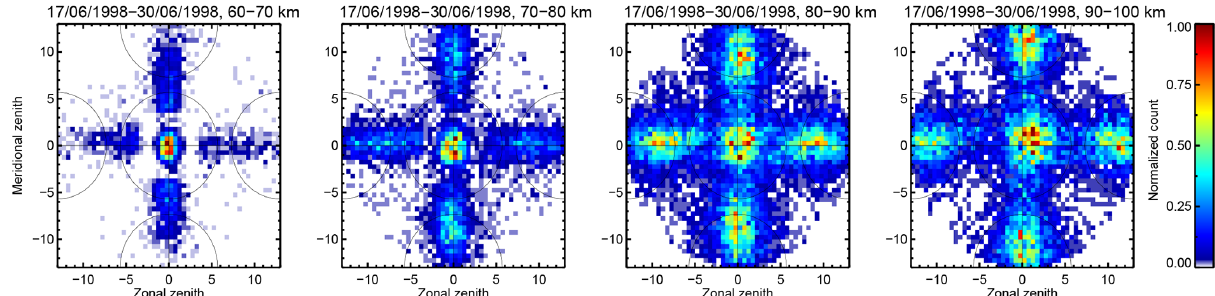
Figure 3. Normalized 2-D histograms of the EBPs estimated by HDI at selected range gates for the June 1998 experiment. The thin black circles approximately denote the half-power half-width contours of the transmitted beams (5.7 ◦ in all cases